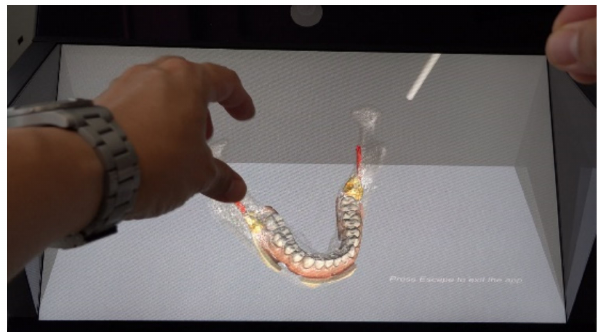
Figure 4. One example of finger manipulation.